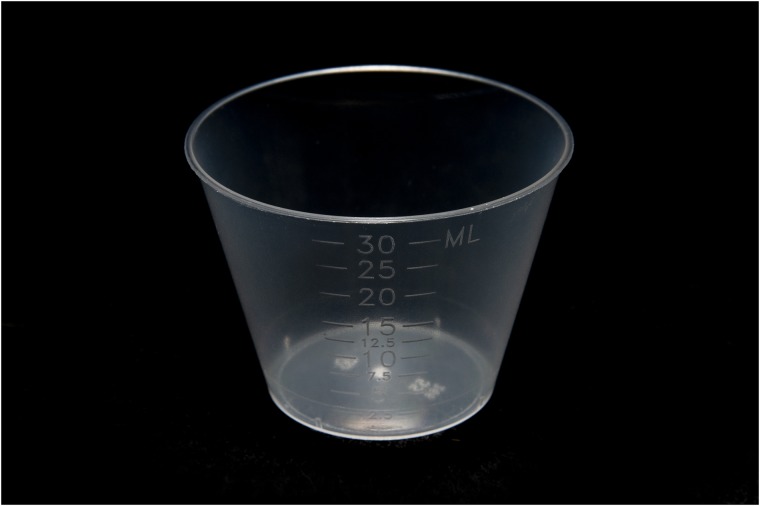
Medicine cup.Photo credit: Seattle Children’s/Erik Stuhaug.